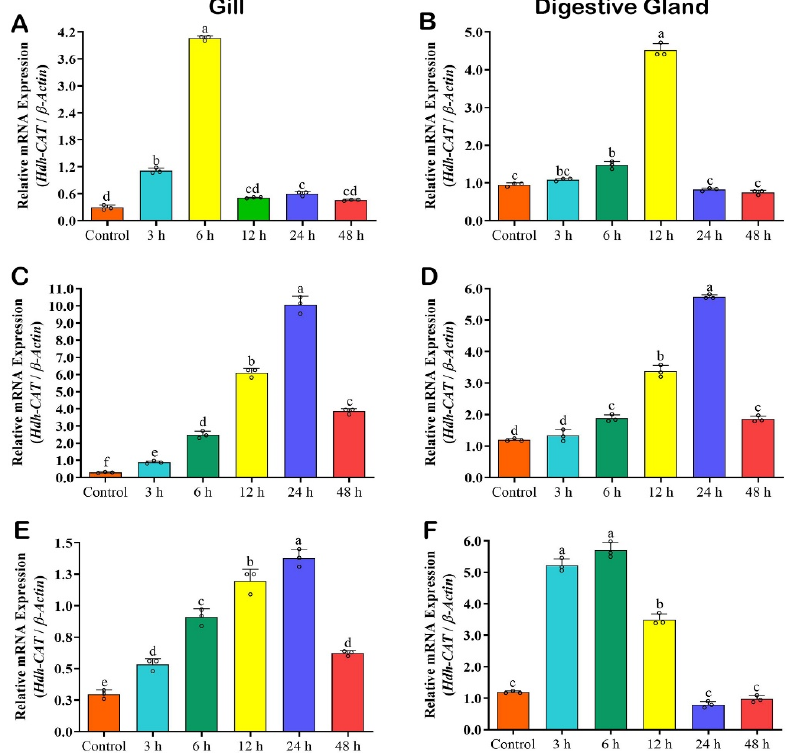
Figure 6. Hdh-CAT mRNA expression levels in immune-challenged Pacific abalone at different time points. ( A ) V. parahaemolyticus -challenged gill samples. ( B ) V. parahaemolyticus -challenged DG samples. ( C ) Lipopolysaccharides (LPS)-challenged gill (GIL) samples. ( D ) LPS-challenged digestive gland (DG) samples. ( E ) Polyinosinic–polycytidylic acid sodium salt (PIC)-challenged gill samples. ( F ) PIC-challenged DG samples. Different letters above the bars indicate significant differences ( p < 0.05).